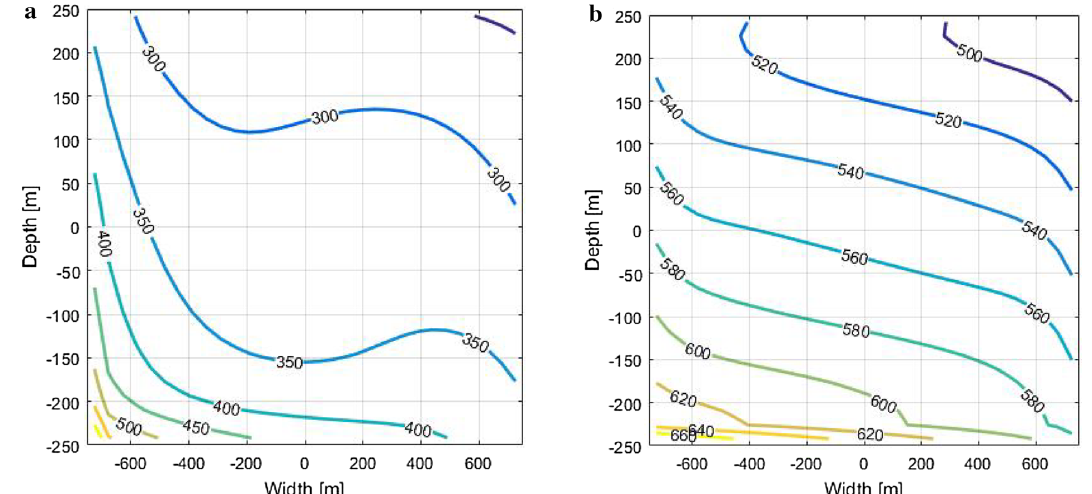
Fig. 12 a Contour plot of mixture density (kg/m 3 ), with natural convection, k = 1 md, gas condensate. b Contour plot of mixture density (kg/m 3 ), with natural convection, k = 1 md, volatile oil